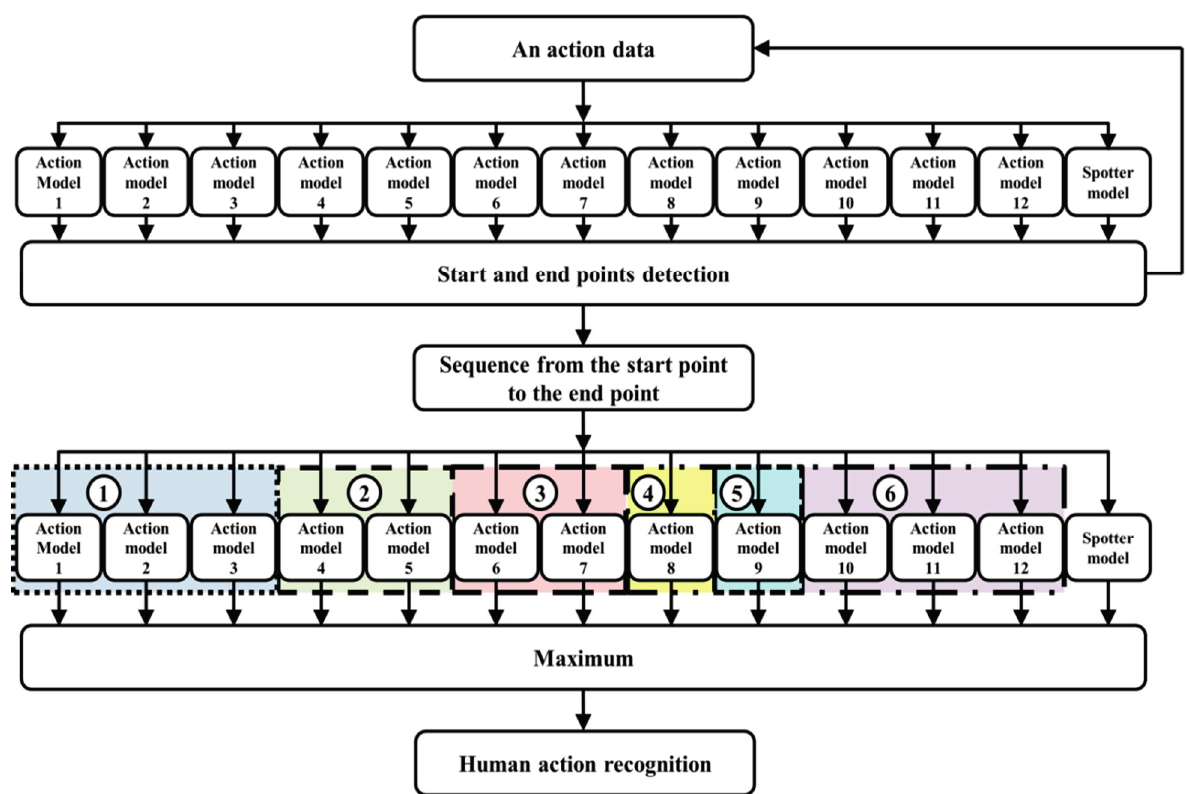
Figure 11. The proposed method for human action recognition.